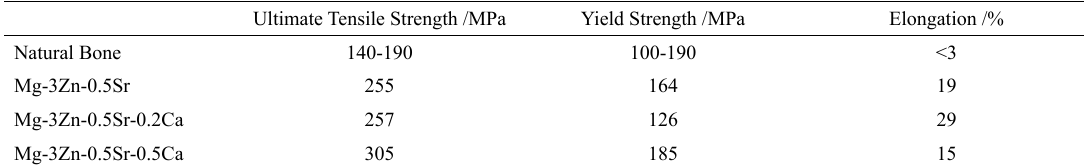
Table 1. The mechanical properties of Mg-3Zn-0.5Sr-xCa alloys Ultimate Tensile Strength /MPa